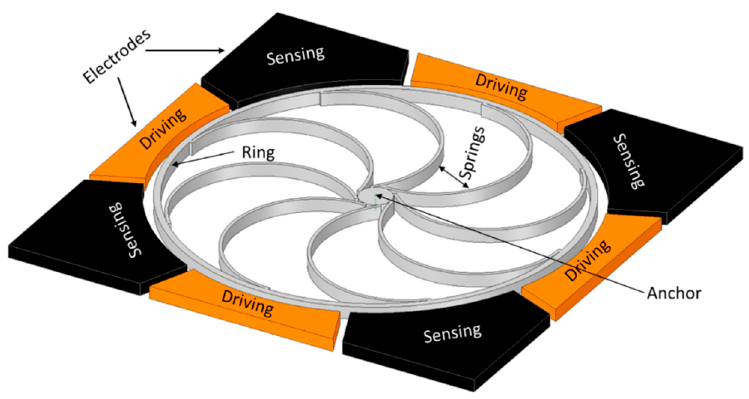
Figure 2. A schematic view of vibratory ring gyroscope.